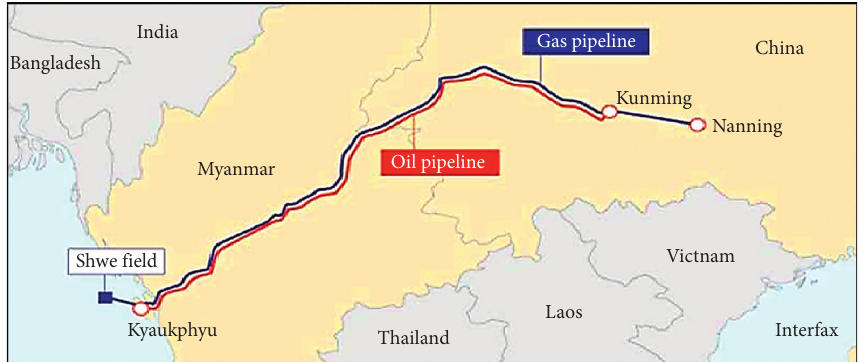
Figure 9: Oil and gas pipeline from Myanmar to China [60].